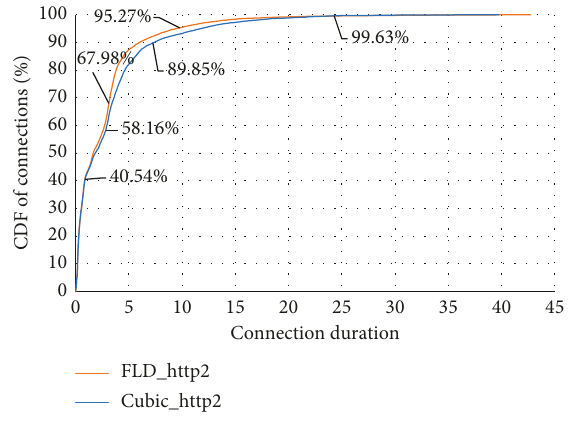
Figure 10: Distribution of connection duration across HTTP/2